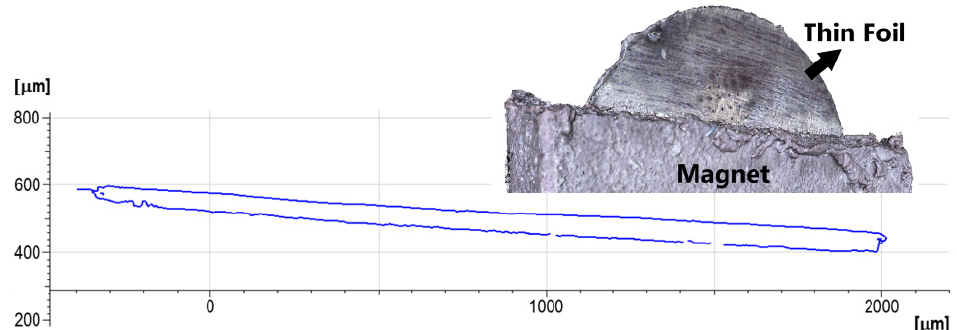
Figure 3 . Profile diagram of the T91 thin foil (in blue) using an optical 3D equipment. The profile diagram was taken in the middle of the sample to measure the average thickness.